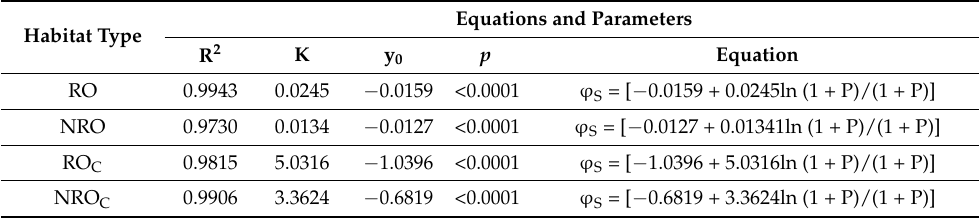
Table 2. Fitting effects and equations of soil water characteristic curves in two habitats.